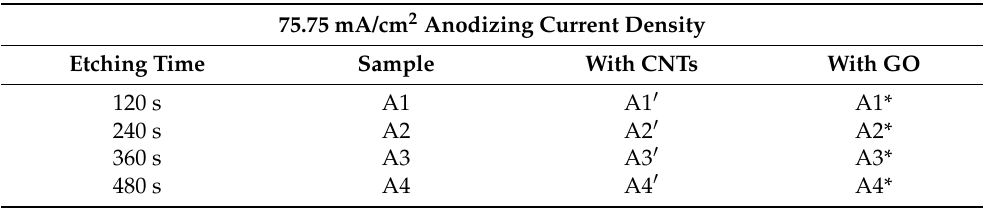
Table 1. List of etching conditions of the SiP layers, Si-n/PSi/CNTs ( ´ ) and Si-n/PSi/GO (*) structures.